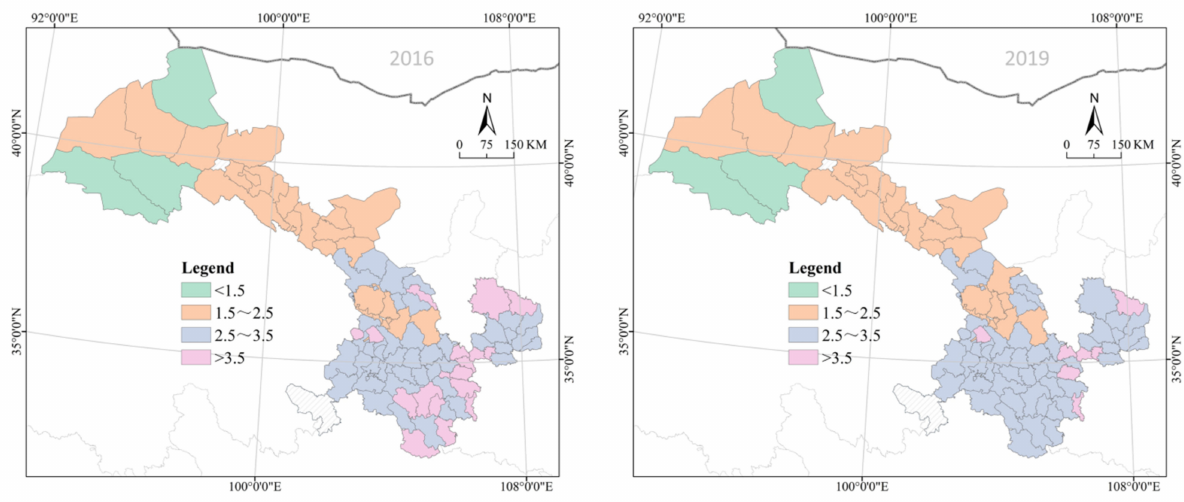
Figure 12. Map made using Pan’s